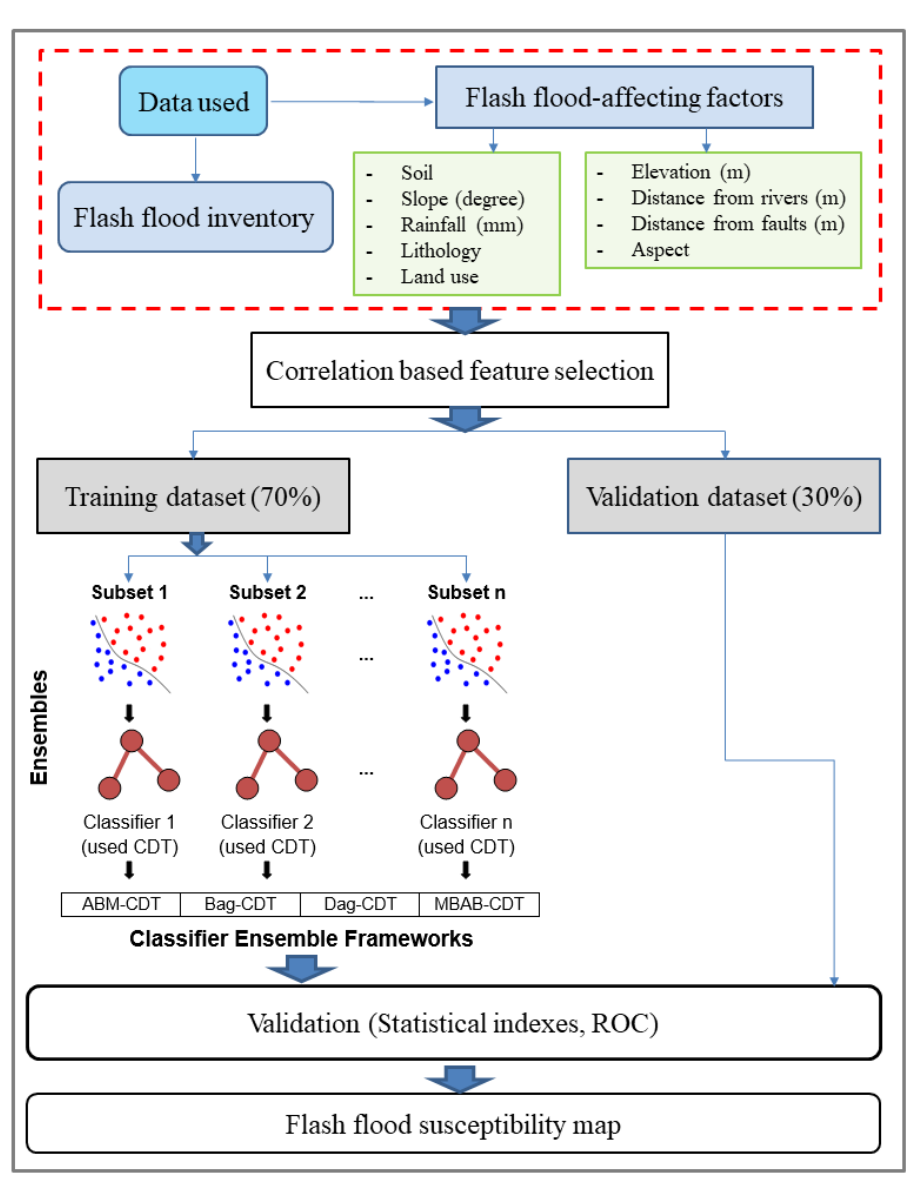
Figure 4. Methodological flowchart of the flash flood susceptibility mapping used in the study .